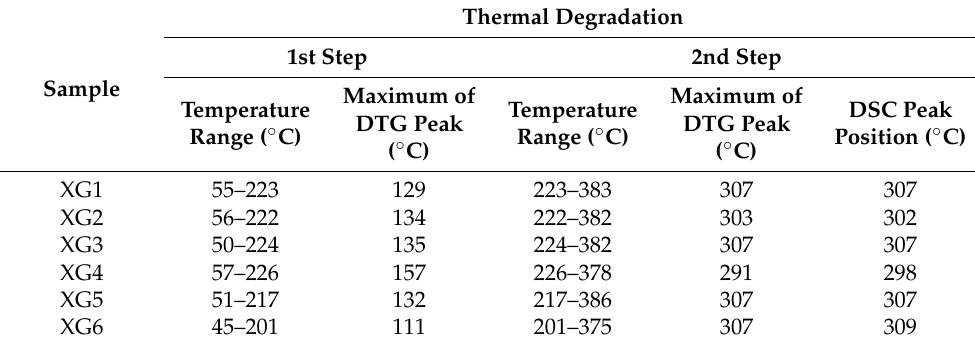
Table 1. The parameters from TG, DTG, and DSC analysis for studied XG1-XG6 silicate xerogels doped with Dy 3+